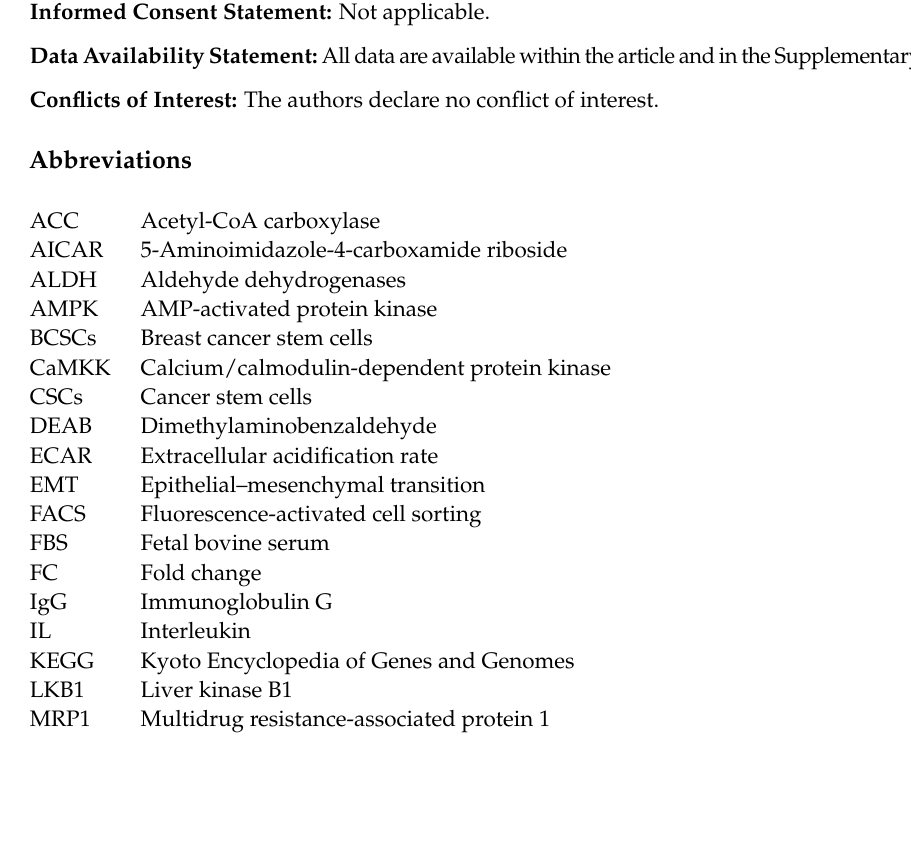
(bottom). Table S1: Sequences of RT-qPCR primers. Table S2: Metabolism-related genes (Microsoft Excel™